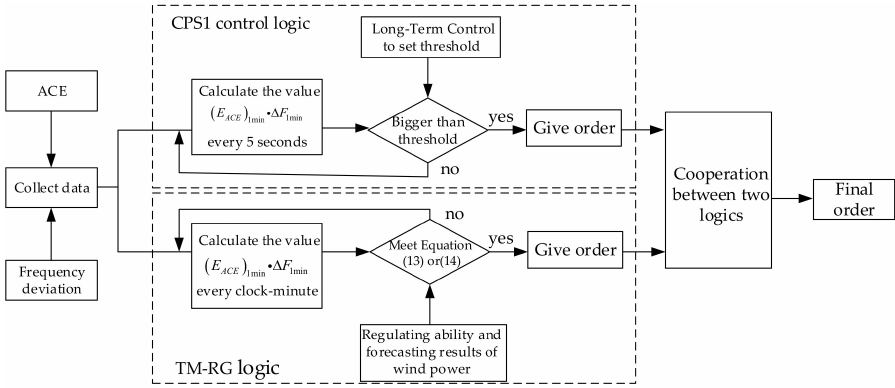
Figure 3. Framework of the cooperation between the Triggered Monitoring and Graded Regulation (TM-GR) logic and the Control Performance Standard 1 (CPS1) control